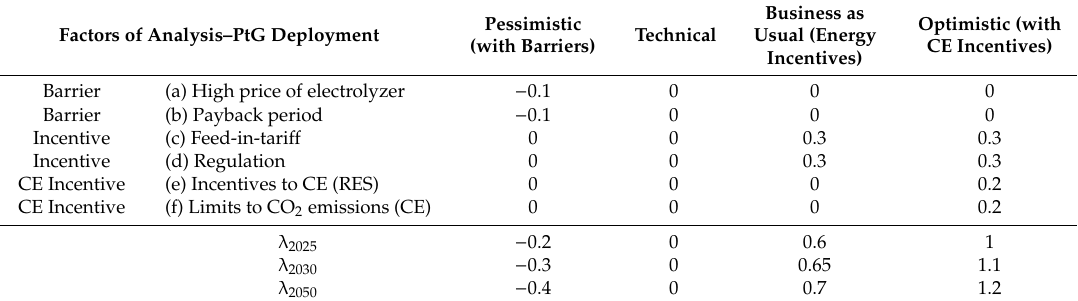
Table 8. Matrix of factors for the PtG scenario